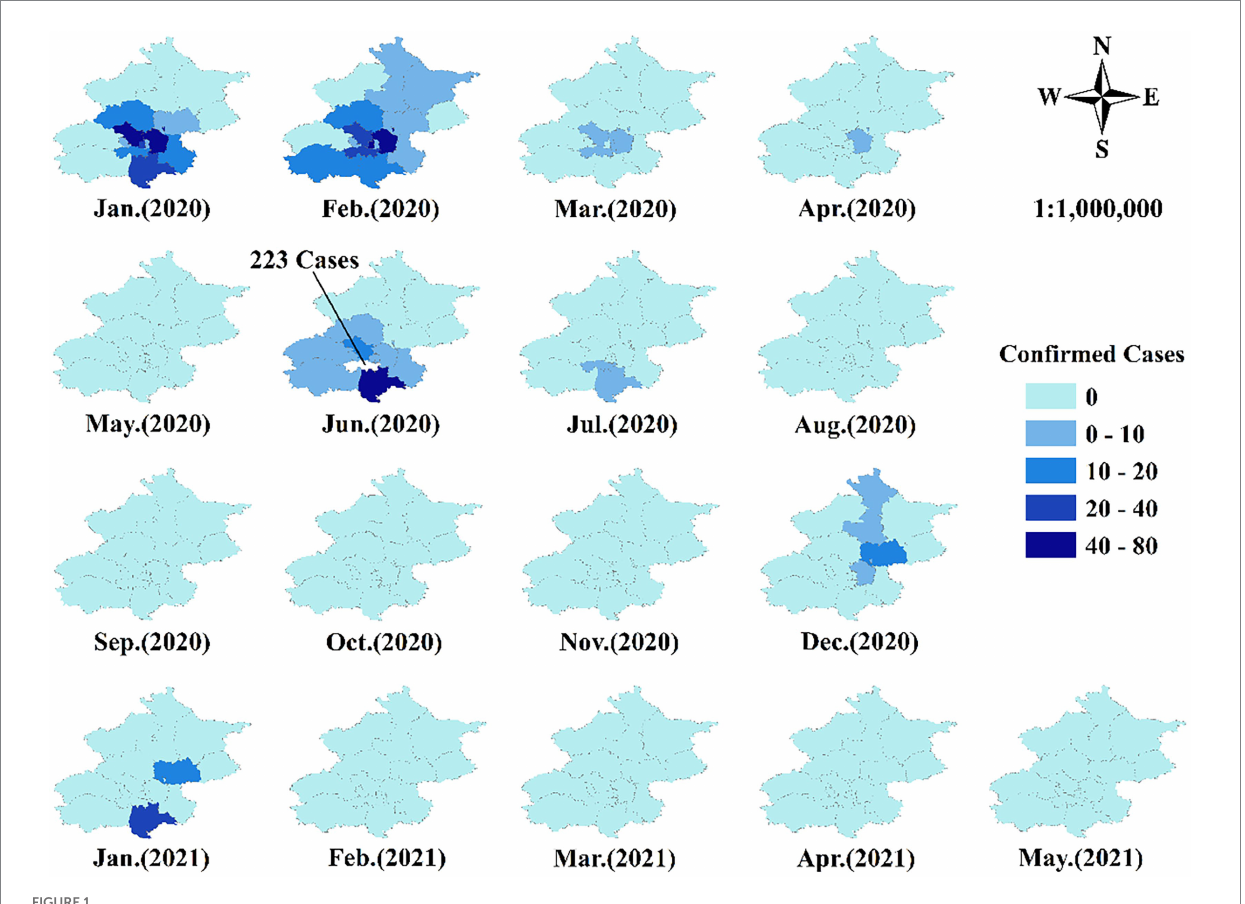
FIGURE 1 Confirmed local cases of COVID-19 from January 2020 to May 2021 in